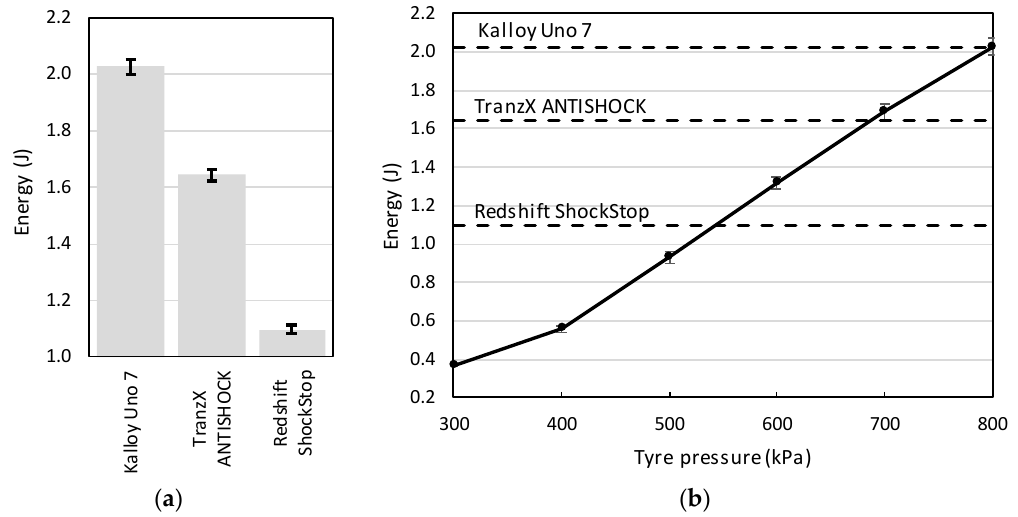
Figure 3. ( a ) Average total transmitted energy for the three stems. ( b ) Average total transmitted energy as a function of the front tyre pressure for the Kalloy Uno 7 stem (solid line). The average total transmitted energy for the three stems at a front tyre pressure of 800 kPa is indicated by the dashed lines. Uncertainty bars are at a confidence level of